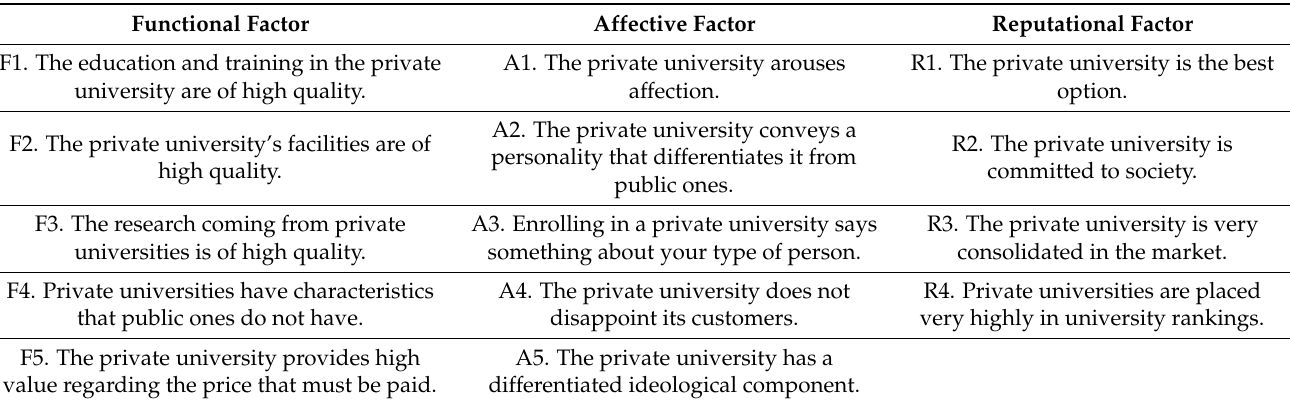
Table 1. Scale to measure the private university’s